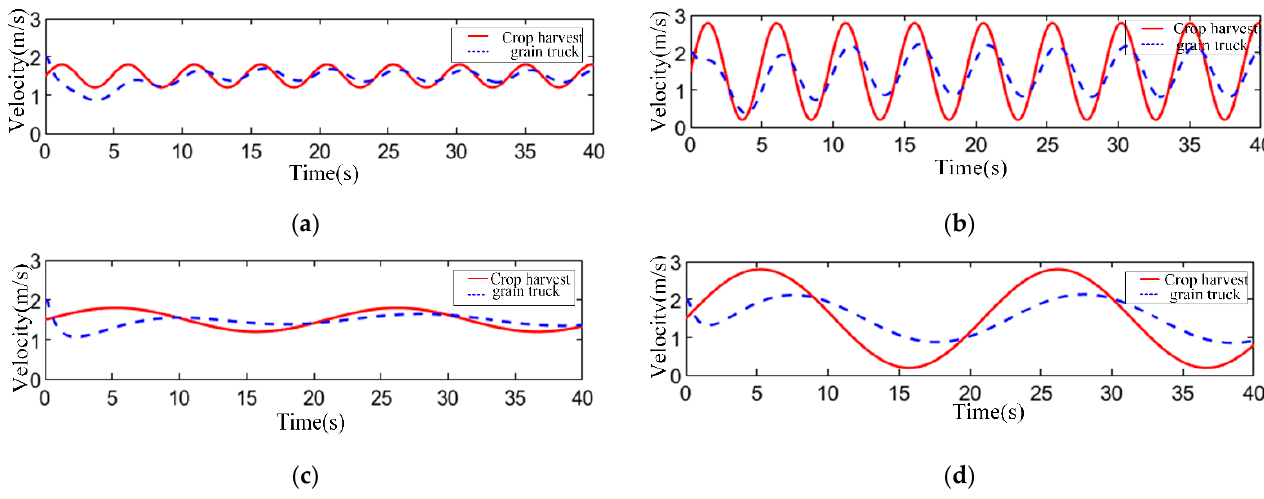
Figure 7. Following simulation diagram under the influence of velocity magnitude fluctuation.